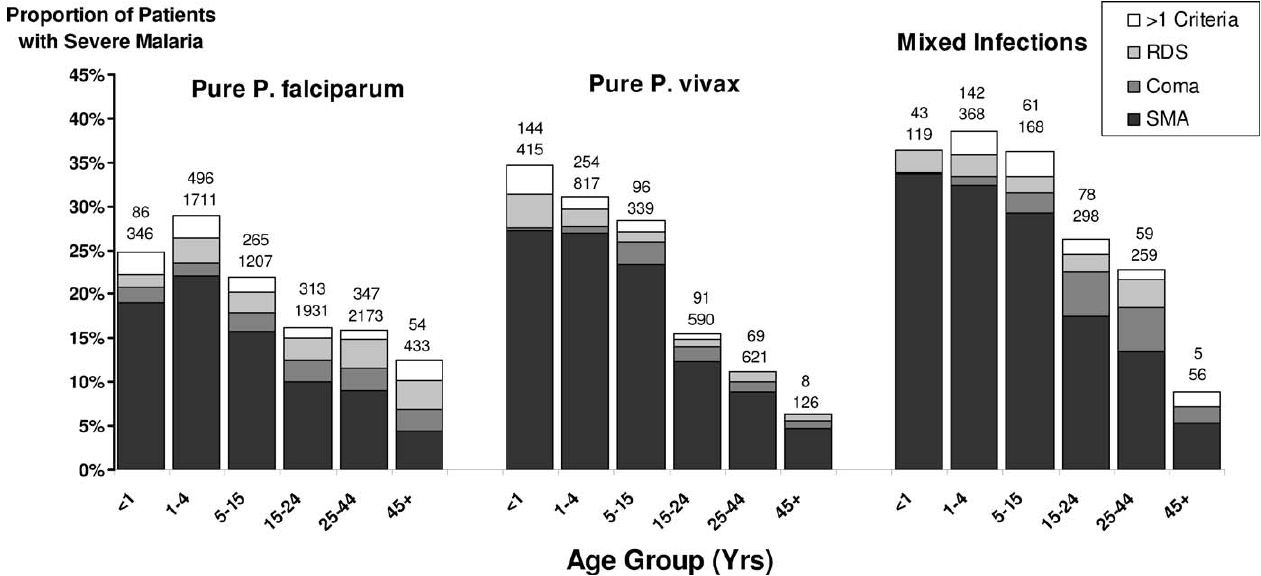
Figure 3. The Prevalence of Severe Disease in Patients Hospitalised with Malaria Stratified by Species of Infection and Age Group Severe disease defined by respiratory distress (RDS), coma, and SMA. For each age group the upper number above each column represents the total number of patients with severe disease (numerator), and the lower number is the total number of patients with the species of infection (denominator). Data on age were unavailable in 50 patients. doi:10.1371/journal.pmed.0050128.g003 PLoS Medicine |